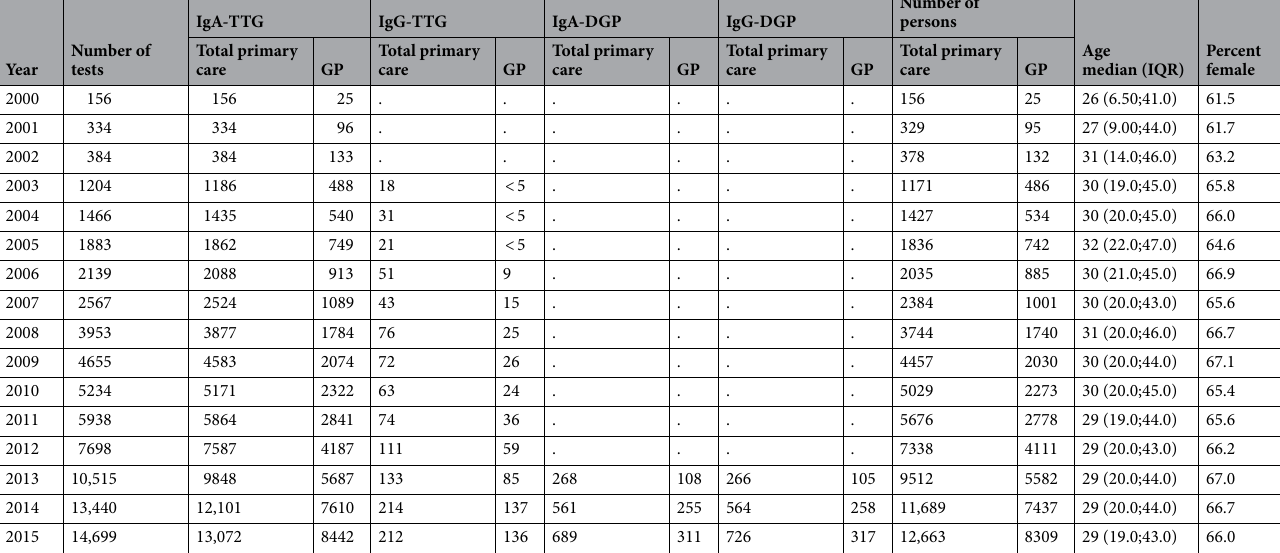
Table 2. Trends in frequency of requisitions of celiac disease antibody tests from primary care, both general practitioners (GP) and private practicing specialists, from 2000 to 2015 . Ig Immunoglobulin, TTG